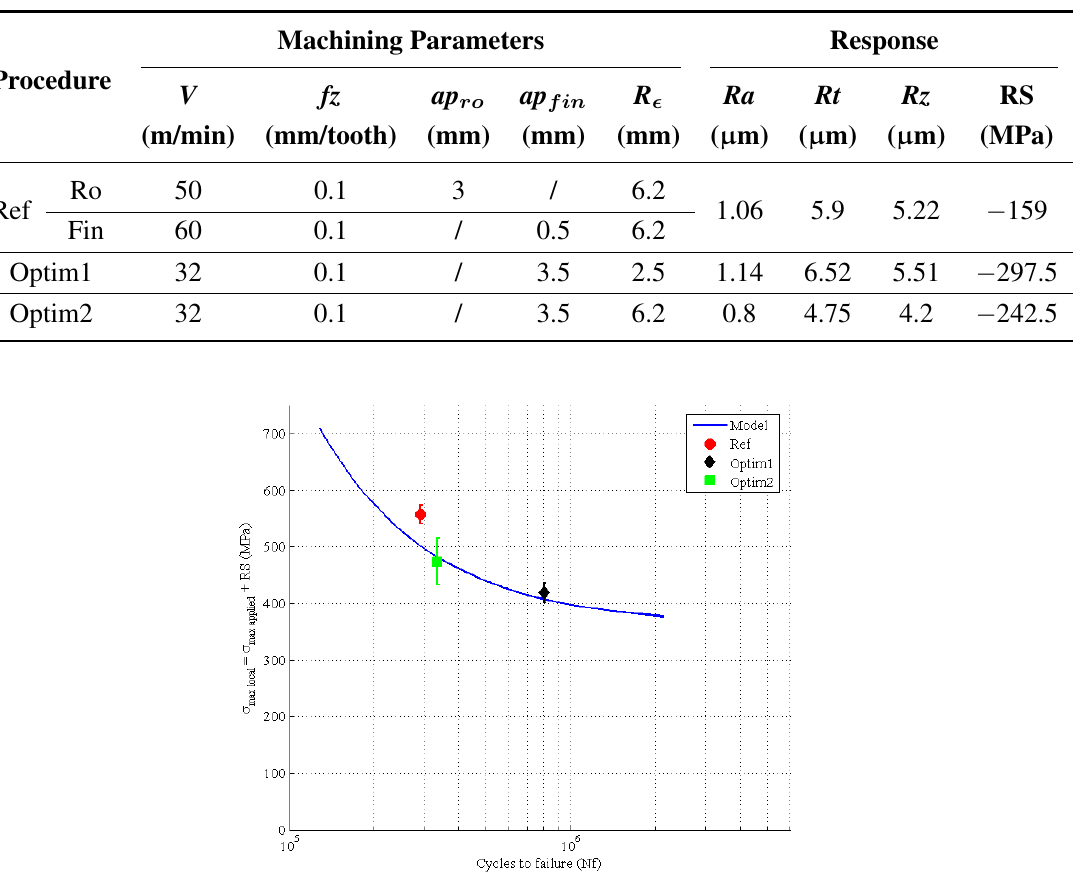
Table 5. Cutting conditions and responses for the Ref and optimized plan of procedure.